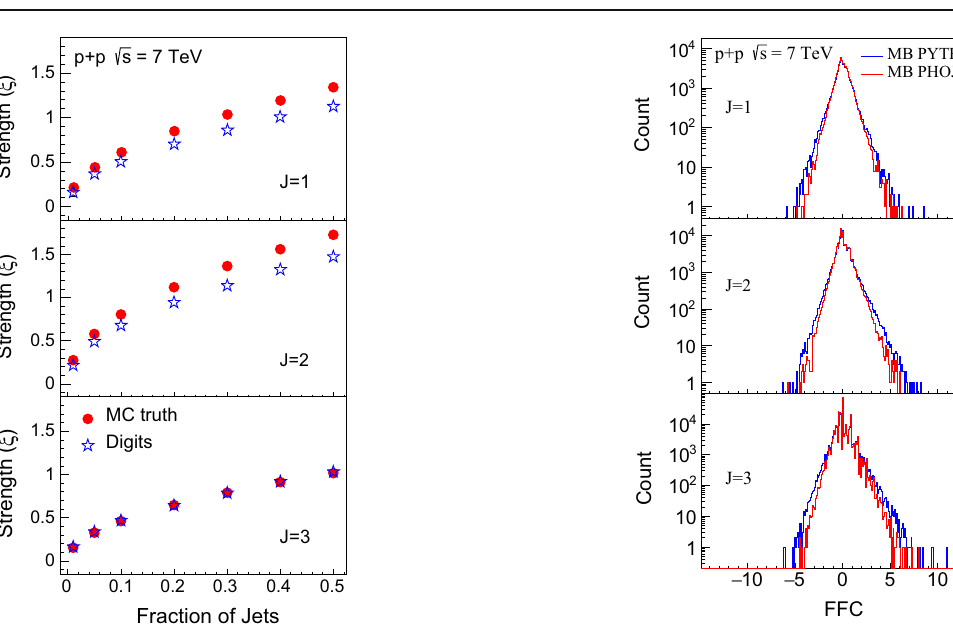
Fig. 8 FFCs distribution in PYTHIA6 and PHOJET for scale J = 1, √ s = 7TeV for MC truth 2, 3 in pp collisions at